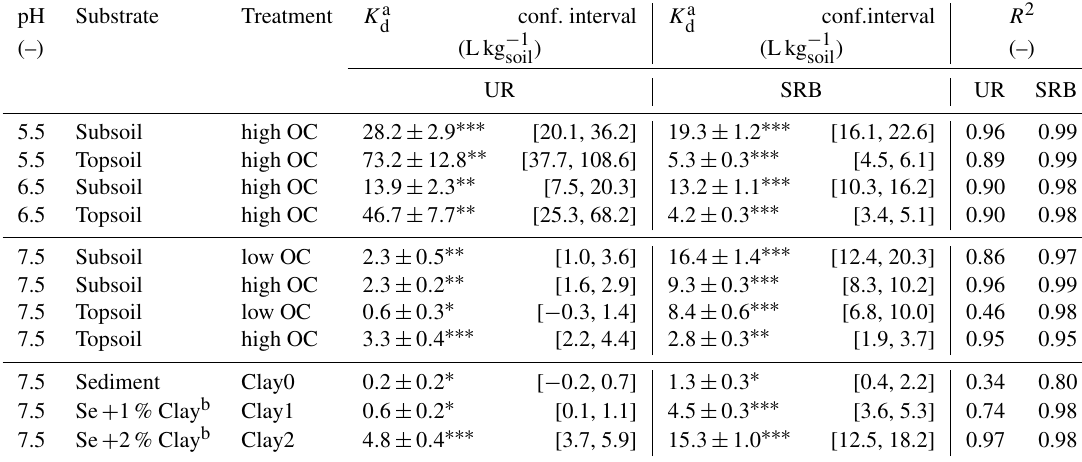
Table 4. K d values for UR and SRB adsorption in topsoil, subsoil and sediment at pH 5.5, 6.5 and 7.5 with different clay and OC treatments. OC treatment “high OC” represents the untreated samples and “low OC” the H 2 O 2 -treated samples. Clay treatments Clay0, Clay1 and Clay2 represent the sediment with 0%, 1% and 2% clay additions, respectively.